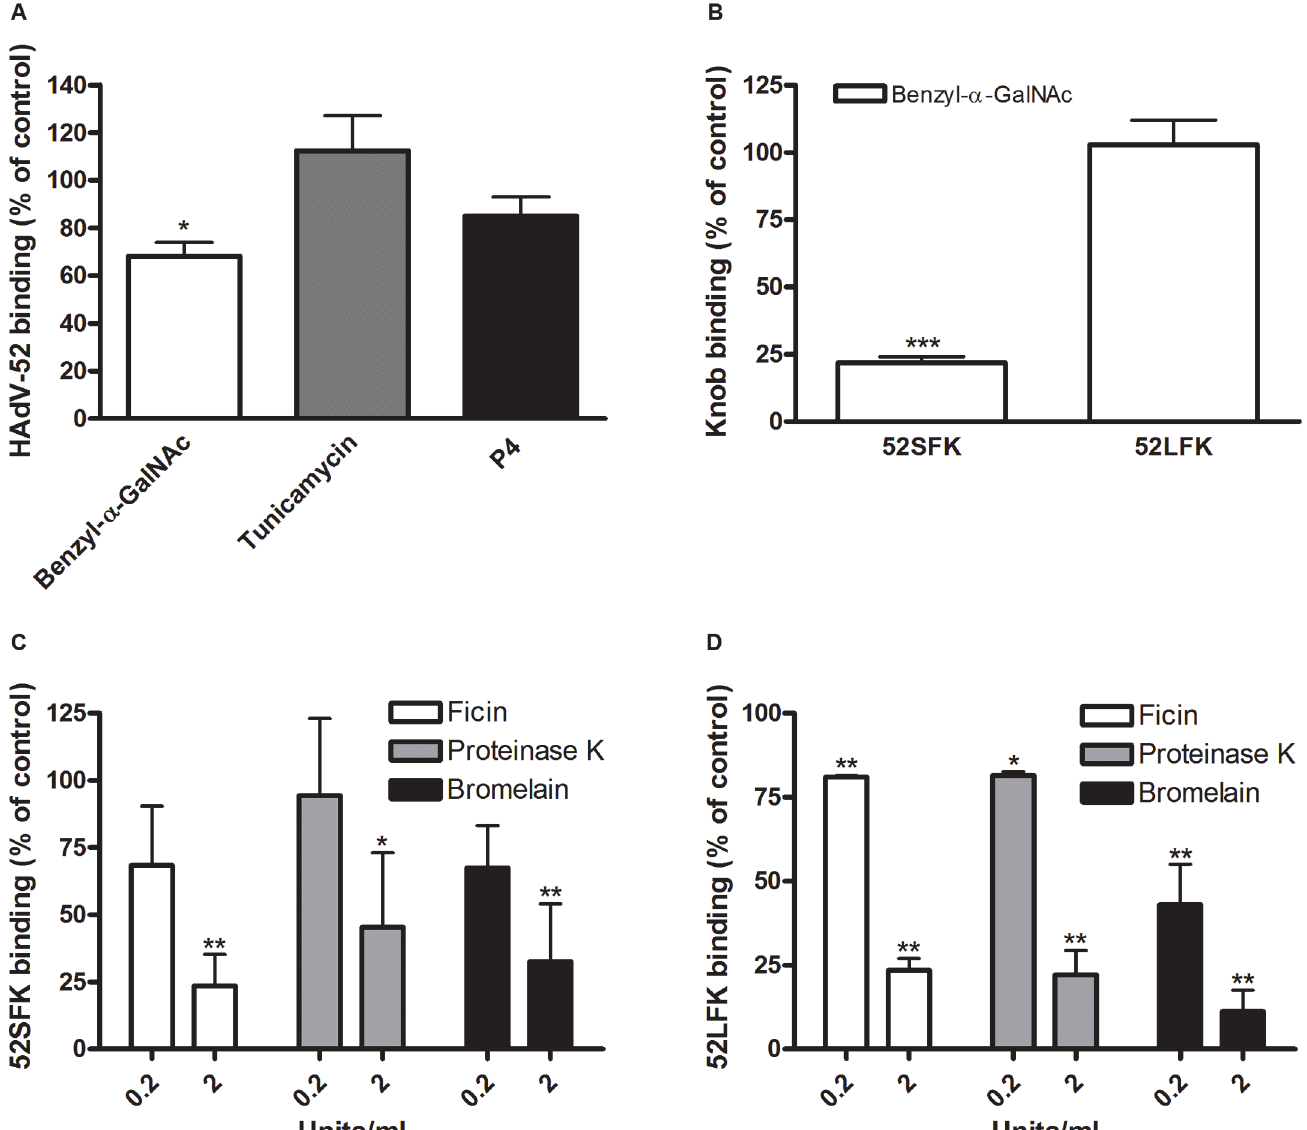
Fig 3. HAdV-52 short fiber knob binds to O -linked glycoproteins on A549 cells. (A) 35 S-labeled HAdV-52 virion binding to A549 cells pretreated with benzyl- α -GalNAc, tunicamycin or P4 (inhibitors of O -linked glycan synthesis, N -linked glycan synthesis, and glycolipid synthesis, respectively). (B) HAdV-52 short fiber knobs (52SFK) and HAdV-52 long fiber knobs (52LFK) binding to A549 cells pretreated with benzyl- α -GalNAc (inhibitor of O -linked glycan synthesis). (C) 52SFK and (D) 52LFK binding to A549 cells pretreated with ficin, proteinase K or bromelain proteases at indicated concentrations. All experiments were performed three times with duplicate samples in each experiment. Error bars represent mean ± SD. * P of < 0.05, ** P of < 0.01 and *** P of < 0.001 versus